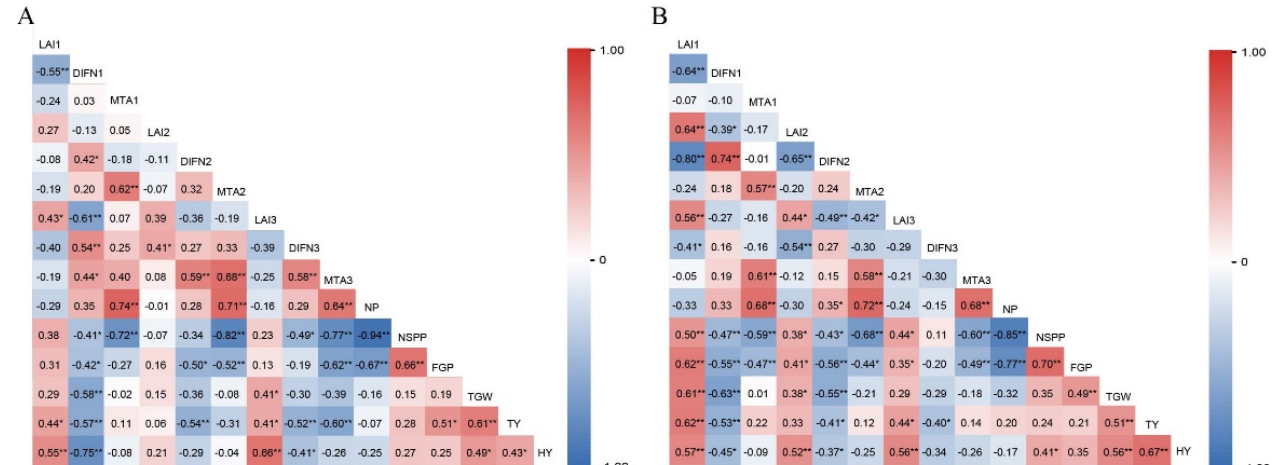
Figure 3. Correlation coefficients between canopy structure index and yield at heading stage of rice. ( A ) Mechanically transplanted carpet seedlings ( R 2 0.05 = 0.16, R 2 0.01 = 0.27). ( B ) Mechanically transplanted pot seedlings ( R 2 0.05 = 0.12, R 2 0.01 = 0.20). LAI1, Leaf area index of 20 cm above the ground; DIFN1, Diffuse non-interceptance of 20 cm above the ground; MTA1, Mean tilt angle of 20 cm above the ground; LAI2, Leaf area index of 50 cm above the ground; DIFN2, Diffuse non-interceptance of 50 cm above the ground; MTA2, Mean tilt angle of 50 cm above the ground; LAI3, Leaf area index of 80 cm above the ground; DIFN3, Diffuse non-interceptance of 80 cm above the ground; MTA3, Mean tilt angle of 80 cm above the ground; NP, Panicles; NSPP, Spikelets per panicle; FGP, Filled-grain percentage; TGW, 1000 ‐ grain weight; TY, Theoretical yield; HY, Harvest yield. Asterisk indi ‐ cates a statistically significant difference (*, p < 0.05; **, p < 0.01).